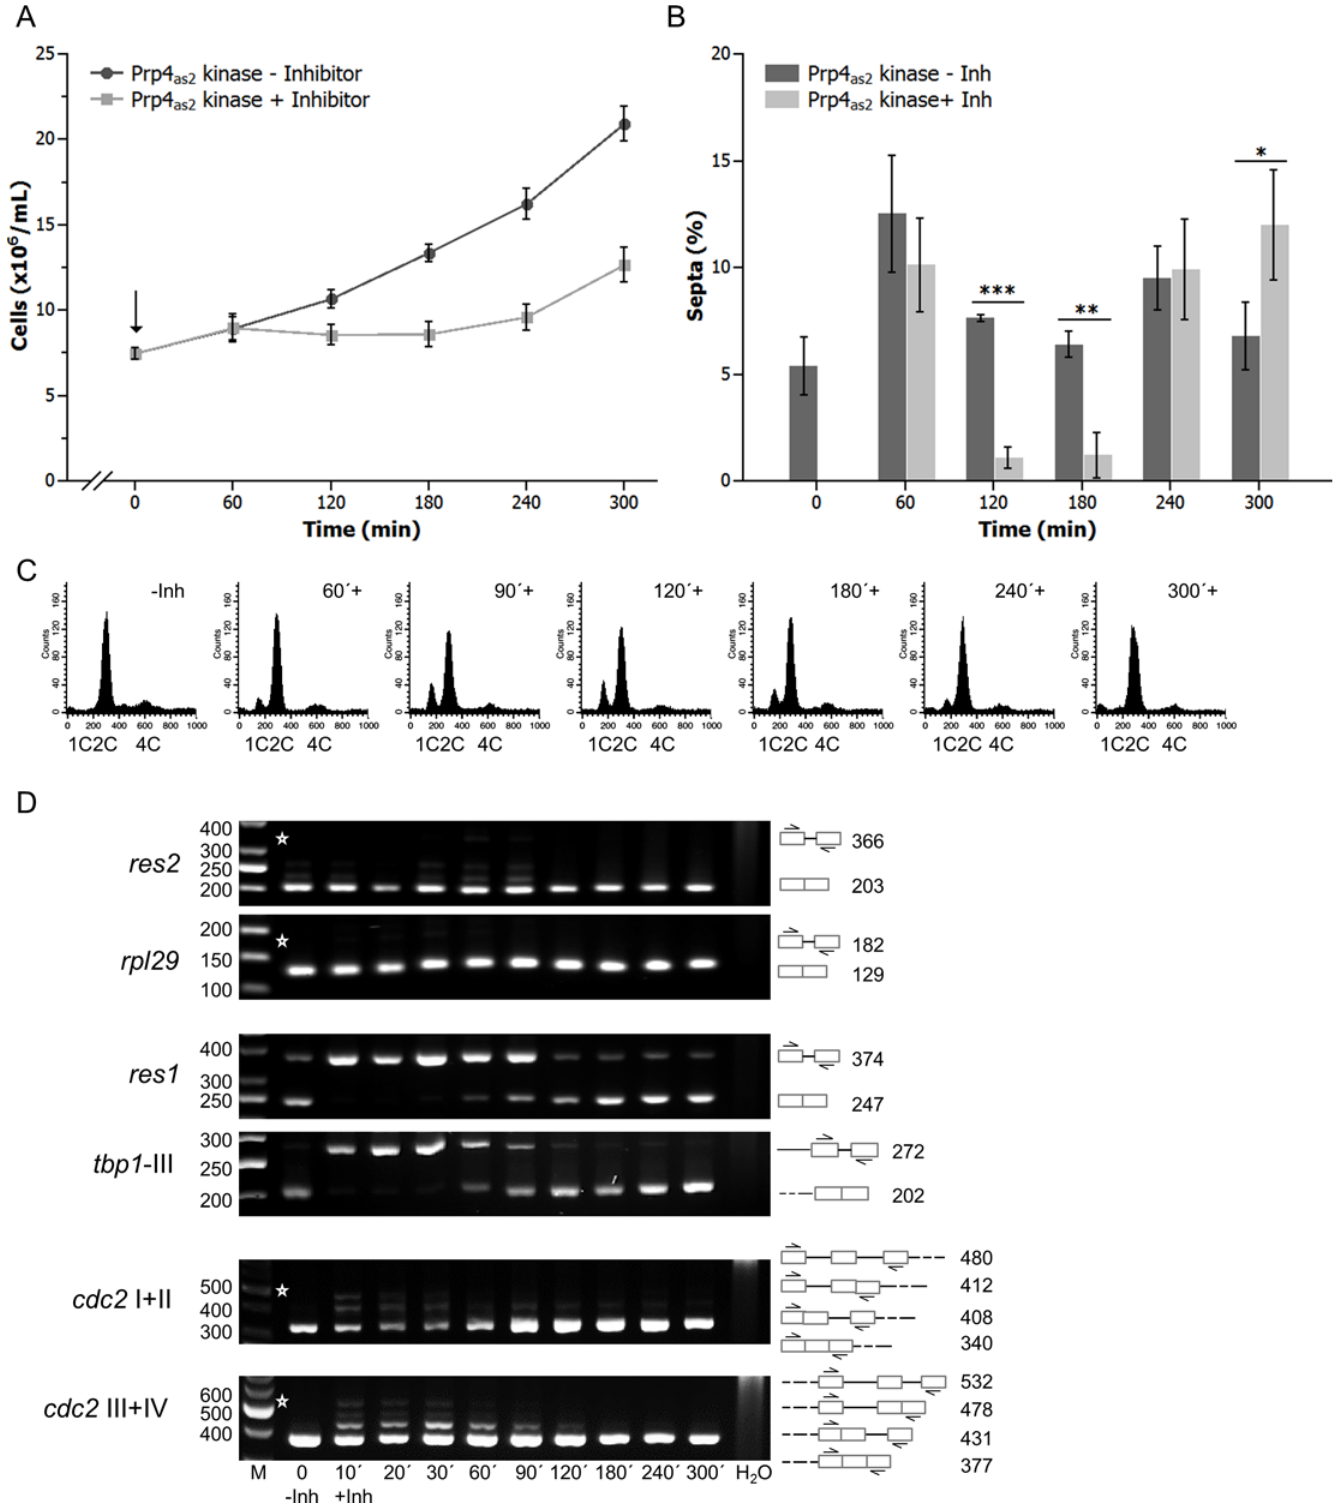
Fig 1. Prp4 as2 kinase and its inhibition with 1NM-PP1 in fission yeast. (A) A strain with the genotype h − s prp4-as2 was grown at 30°C to early log-phase. The inhibitor 1NM-PP1 was then added to the culture medium (0 hours, arrow, # ) at a final concentration of 10 μ M. Growth of the culture was monitored by counting the number of cells/mL (squares) relative to a culture growing in the absence of inhibitor (circles). The error bars indicate standard deviation. (B)